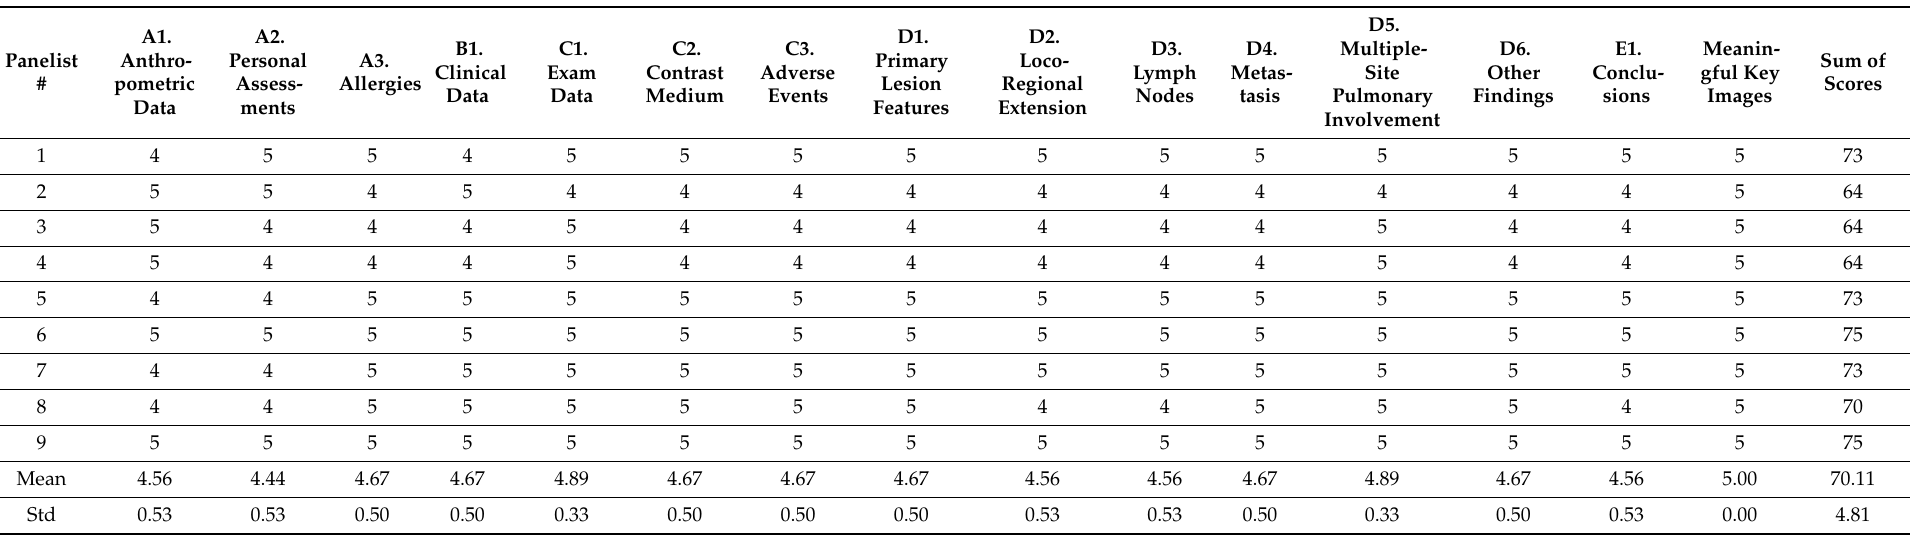
Table 2. Single scores and sums of scores of panelists for staging in the SR (round